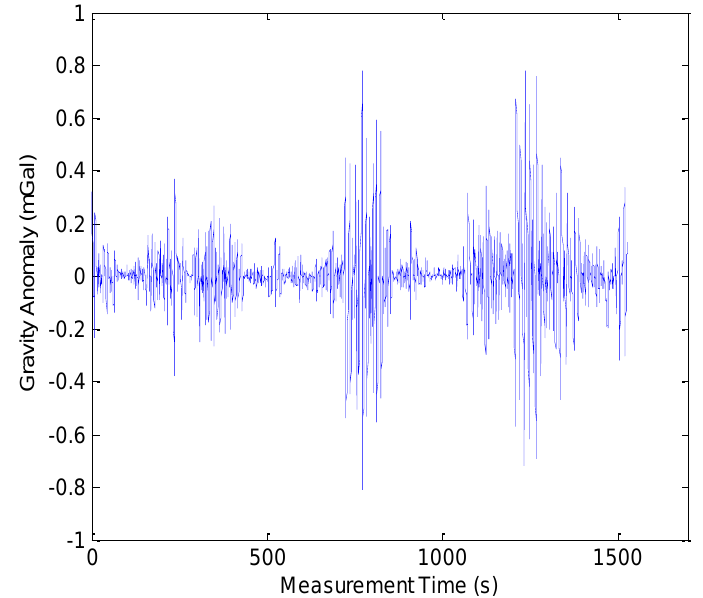
Figure 13. Reconstruction error of NIPM in